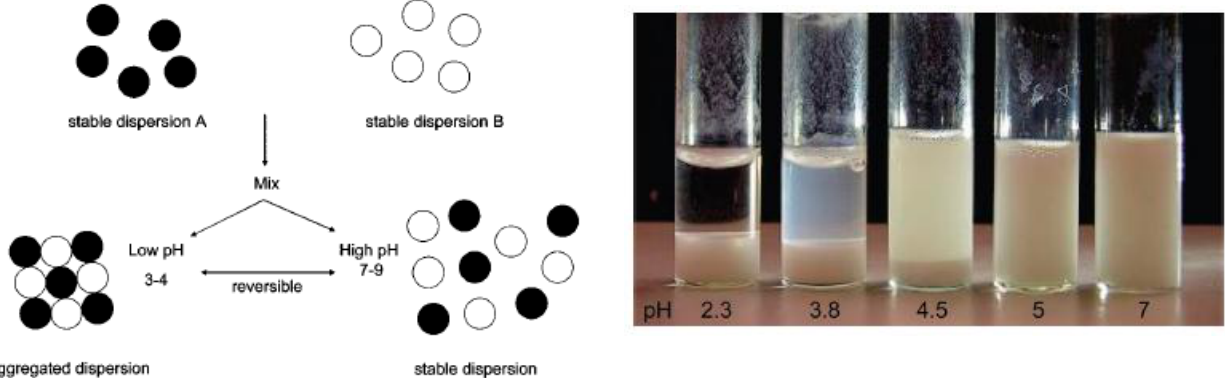
Figure 2. Schematic of the heteroaggregation process (left) and dispersions of mixed carboxylic acid functionalized and poly(ethylene oxide) surface functionality (PEO) functionalized silica particles over the pH range 2–7 (reproduced with permission from reference